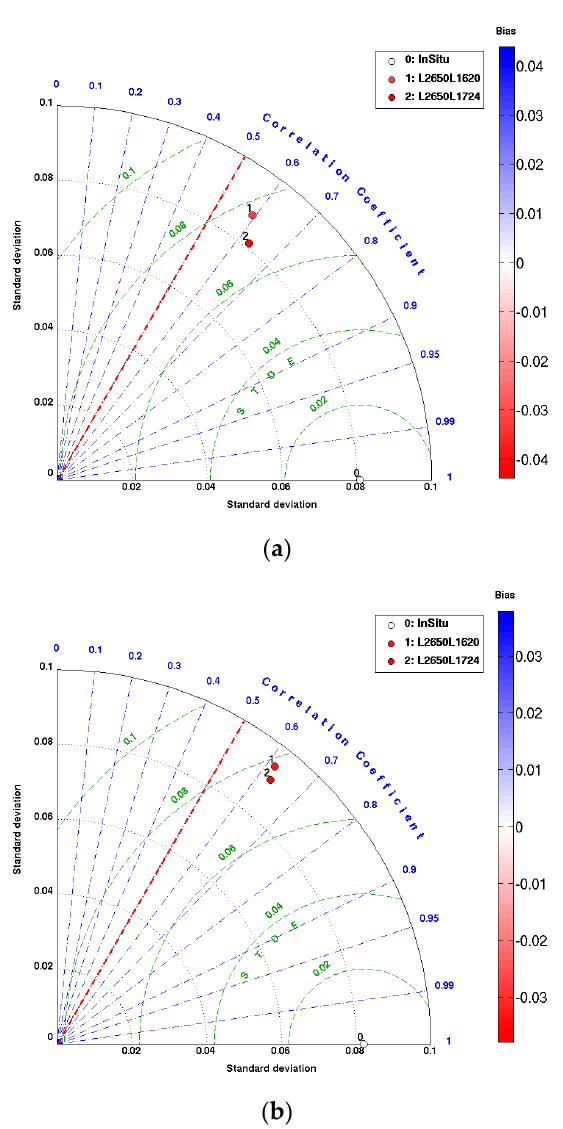
Figure 22. Taylor diagram of overall retrieved soil moisture time series with respect to in-situ measurement time series for ascending orbits ( a ) and descending orbits ( b